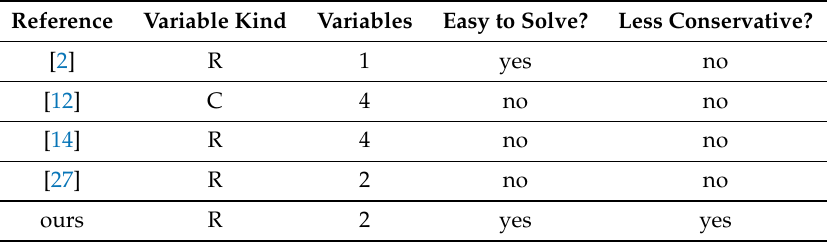
Table 1. Comparisons with existing